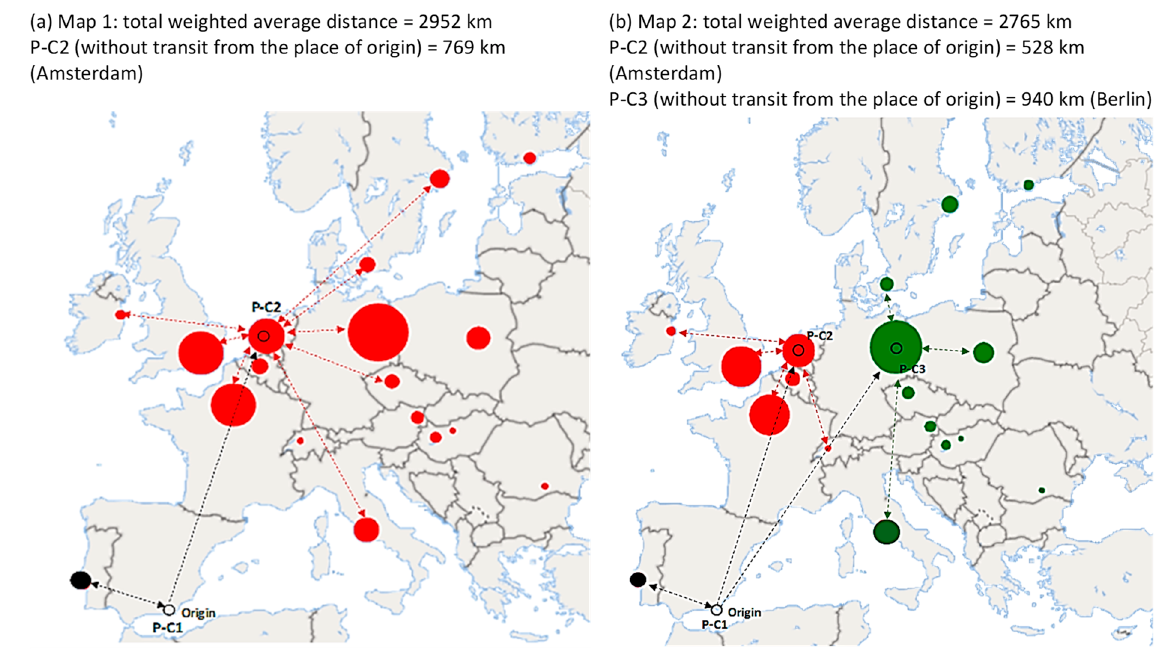
Figure 5. Results of the p-center model ( p = 2 and p = 3). Lines: only samples of routes are shown. Each color represents the customer allocation by the redistribution center. Source: own elaboration.